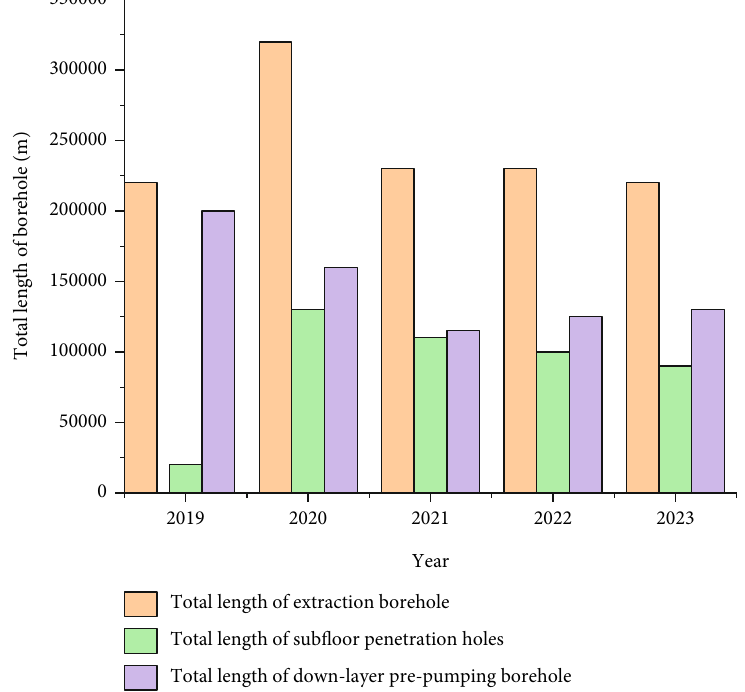
Figure 2: Planned drilling volume in the next fi ve